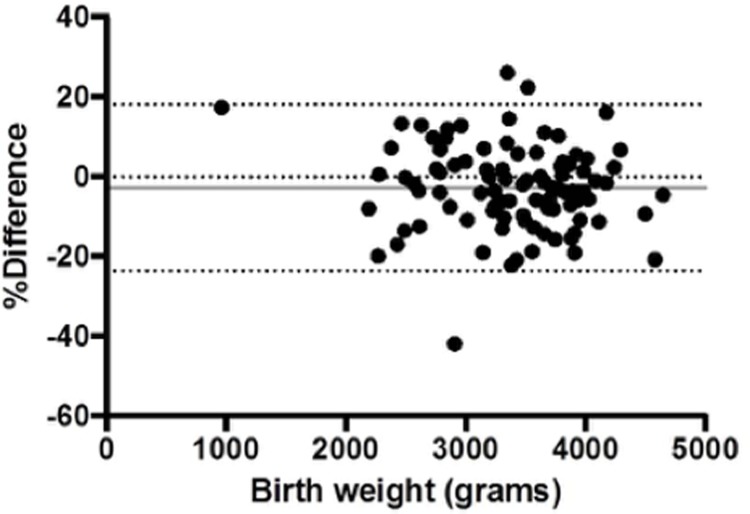
Accuracy of fetal weight estimation within seven days of birth.Bland-Altman plot comparing the difference between estimated fetal weight and actual birth weight (y axis) to the birth weight itself (x axis) for deliveries occurring between 0–7 days from study enrolment. This shows minimal systematic error in estimated fetal weight (grey solid line). The dotted lines show the limits of agreement.